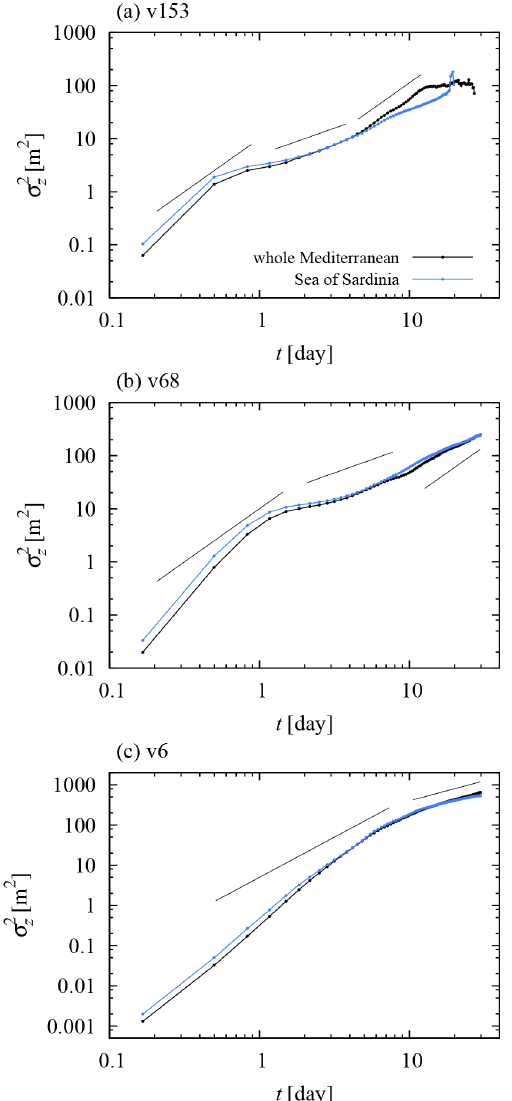
Figure C2. Variance of depth reached by all sinking particles (in black) and those initialized in the Sea of Sardinia (in blue; longi- tudes in [ 5 ◦ , 6 . 9 ◦ ] , and latitudes in [ 37 . 5 ◦ , 42 ◦ ] ) as a function of time. See text for details. Straight lines represent power laws for reference, with exponents 1 and